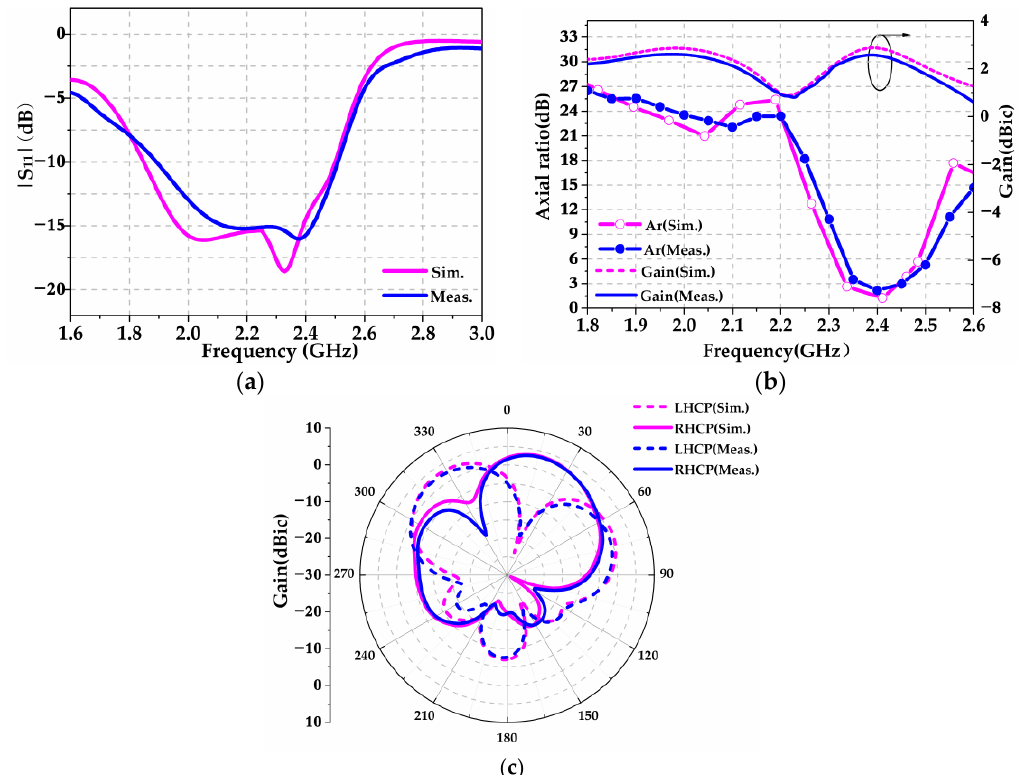
Figure 19. Diagram of State-IV with liquid metal filled in.